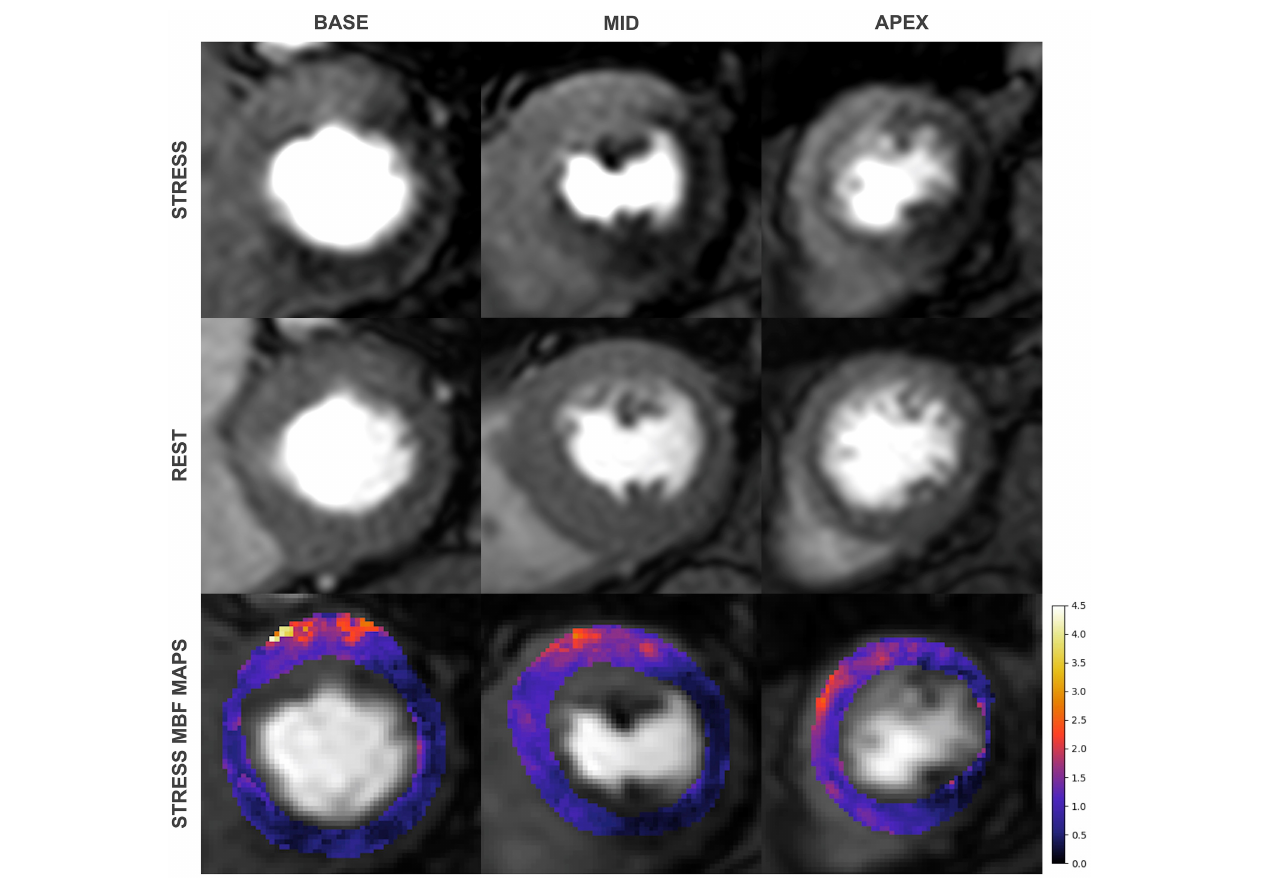
FIGURE 5 | First-pass perfusion images during adenosine induced stress (top) and at rest (middle) with corresponding pixel-wise myocardial blood flow (MBF) maps (bottom) from a 79-year old man with significant 3 vessel disease on invasive coronary angiography. Qualitative assessment identifies inducible perfusion defects in the left circumflex and right coronary artery territories but only perfusion mapping identifies 3 vessel